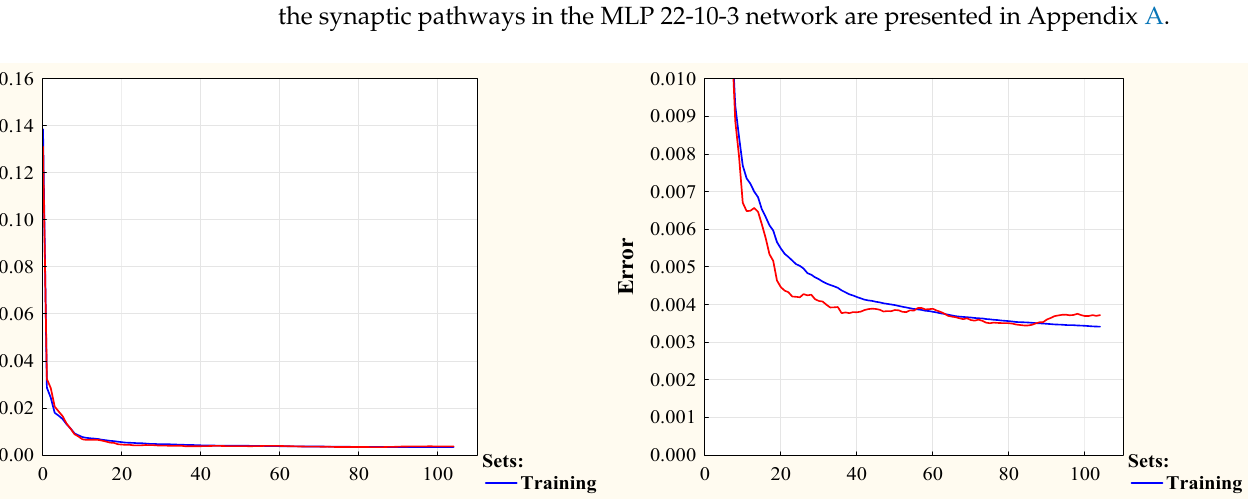
Table 5. List of the artificial neural network with 12 input variables.